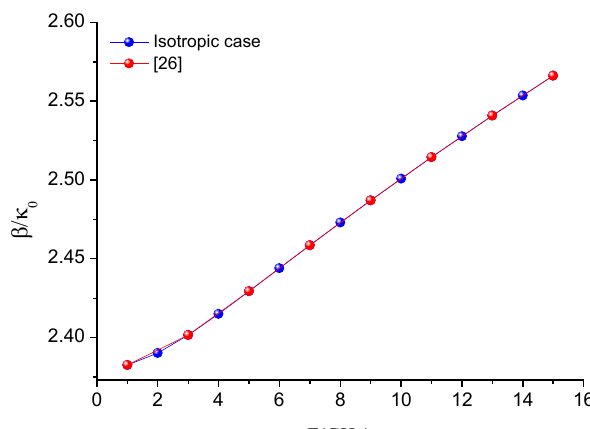
Figure 2: Dispersion characteristics of the dominant mode compared with literature.